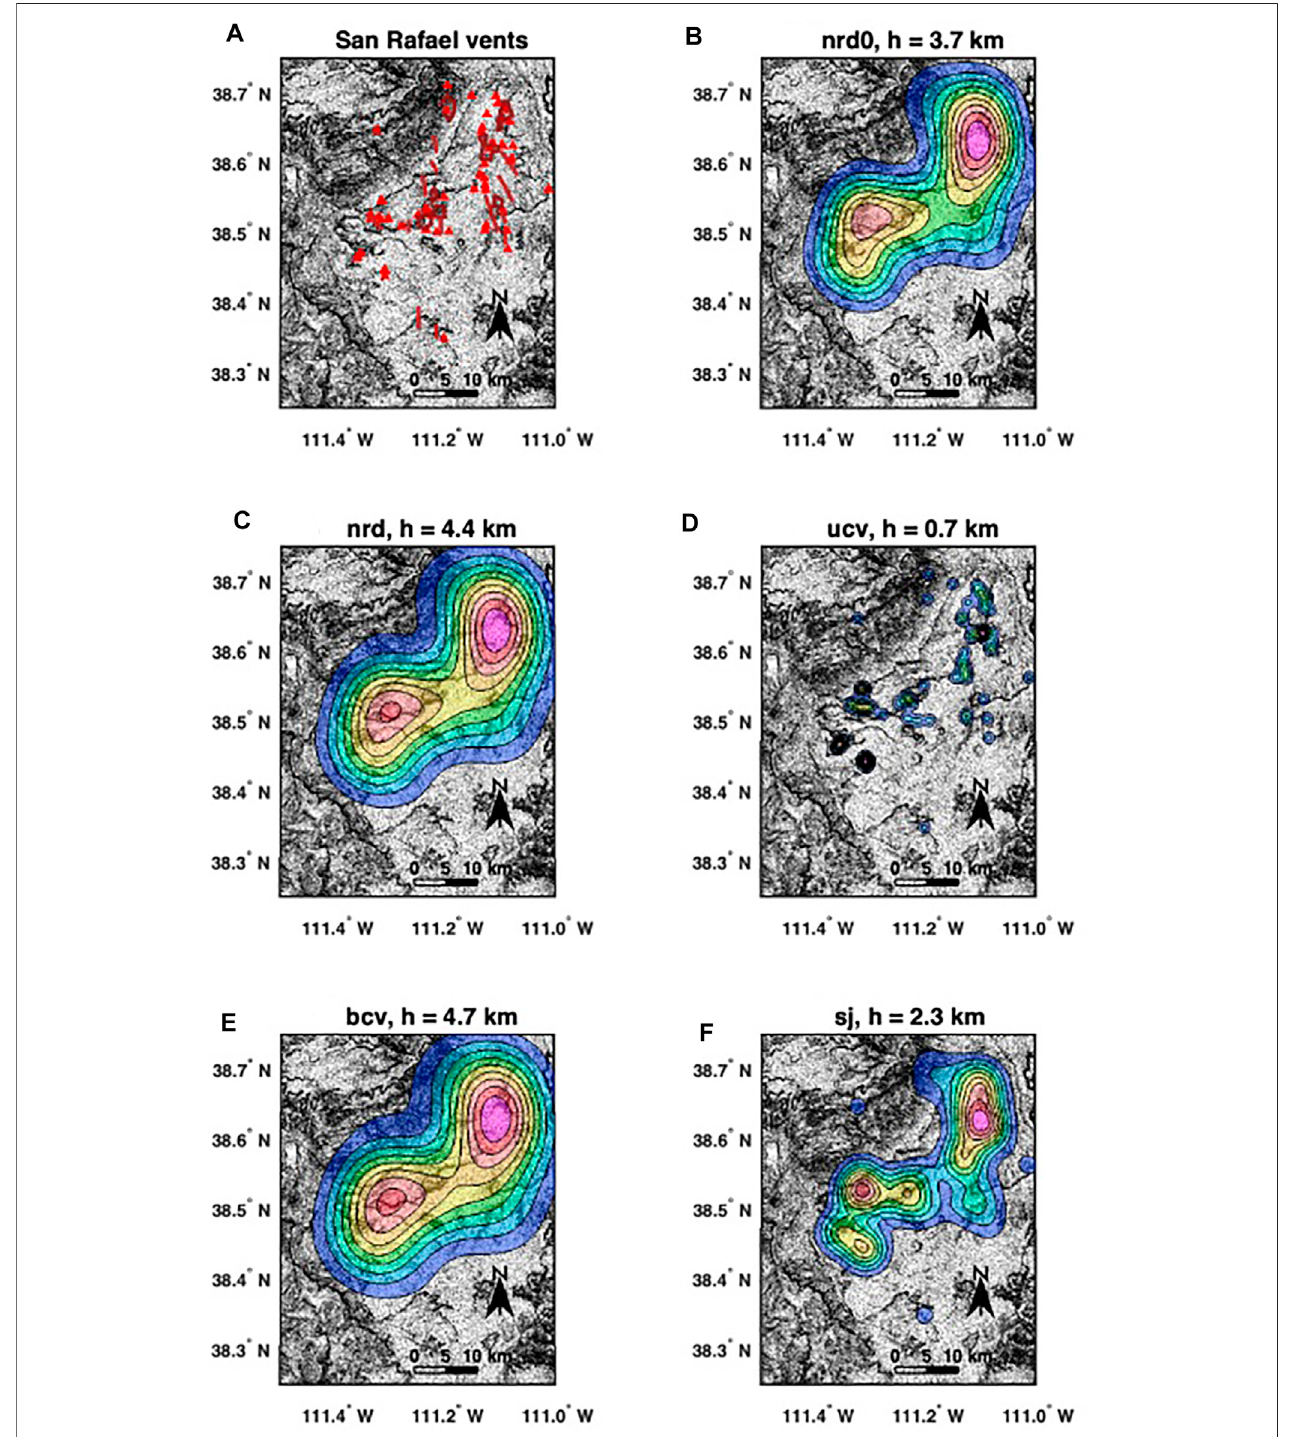
FIGURE4 | Estimated PDFs using the selector and corresponding bandwidth asindicated on top ofeach panel. The fi rst panel (A) shows the location ofthe vents used for the calculations (red triangles); the dykes and sills identi fi ed by Kiyosugi et al. (2012) are indicated with the red lines. San Rafael example.